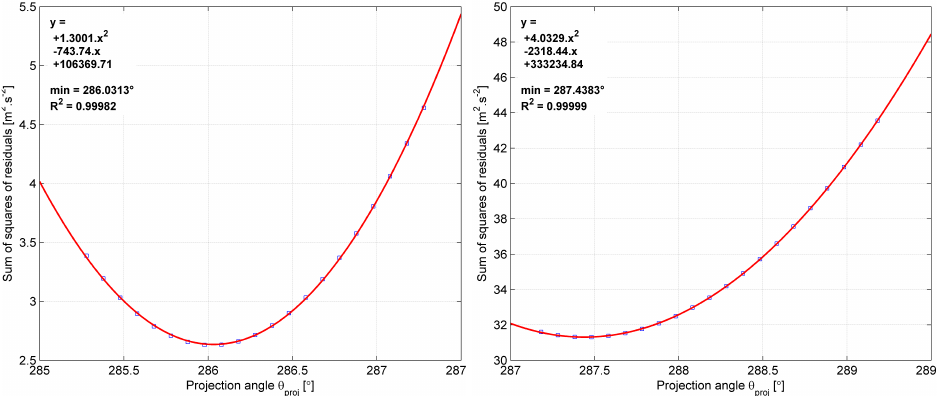
Figure 8. LOS direction evaluation using the RSS process. Left : 5B; Right :